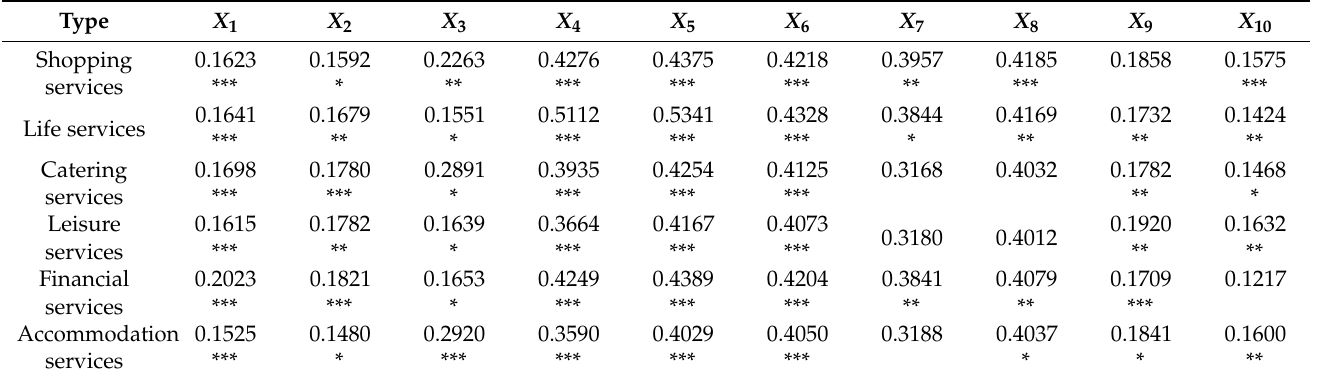
Table 7. Factor detection results of factors influencing the spatial characteristics of different types of market services industries in Wuhan city’s new urban